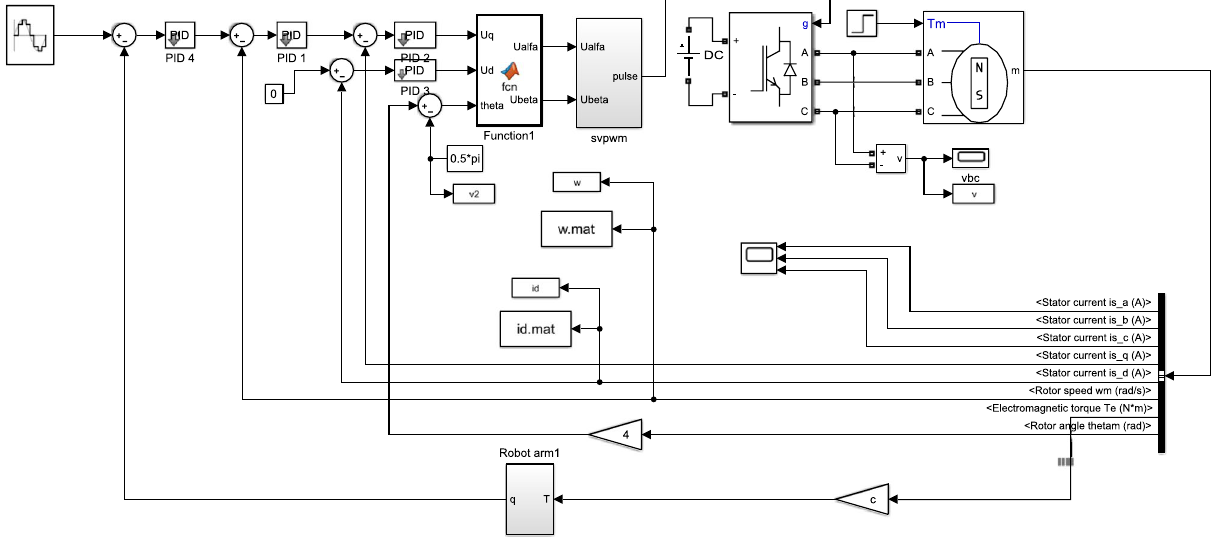
Figure 11. The simulation model of closed-loop drive system of